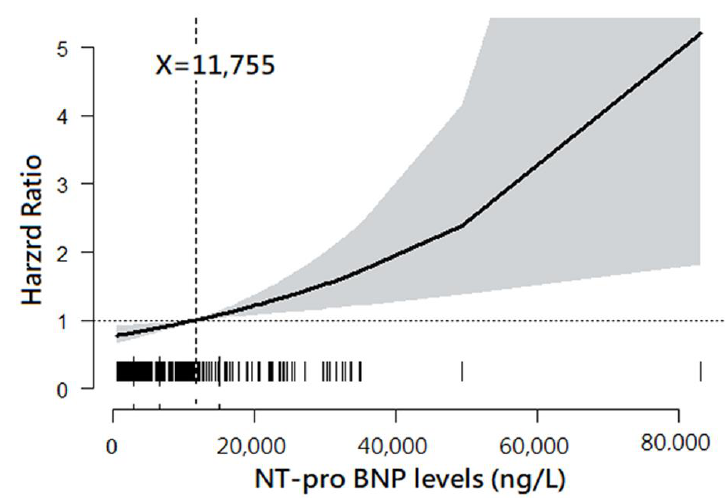
Figure 1. Association between plasma N-terminal pro-brain natriuretic peptide (NT-proBNP) levels and 12-month mortality. Note: The plot was drawn using a general additive model. The best cut-point of plasma NT-proBNP level was 11,755 ng/L.